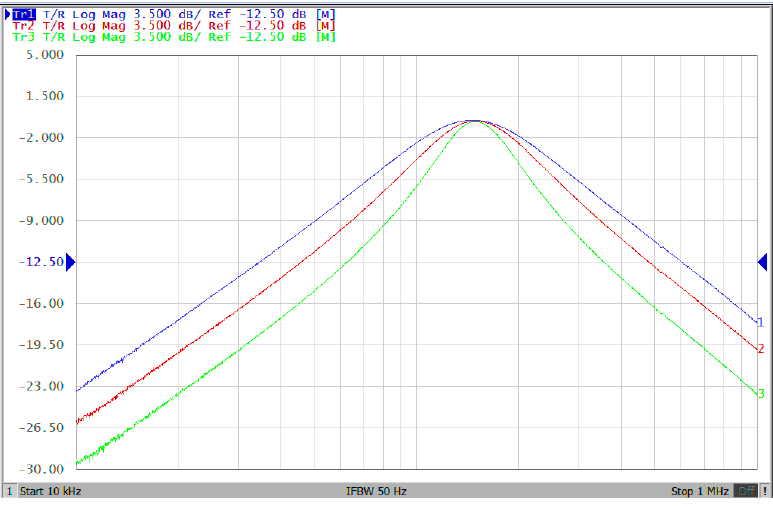
Figure 40. Experimentally observed gain responses of the BP filters realized by varying Q while keeping f o .